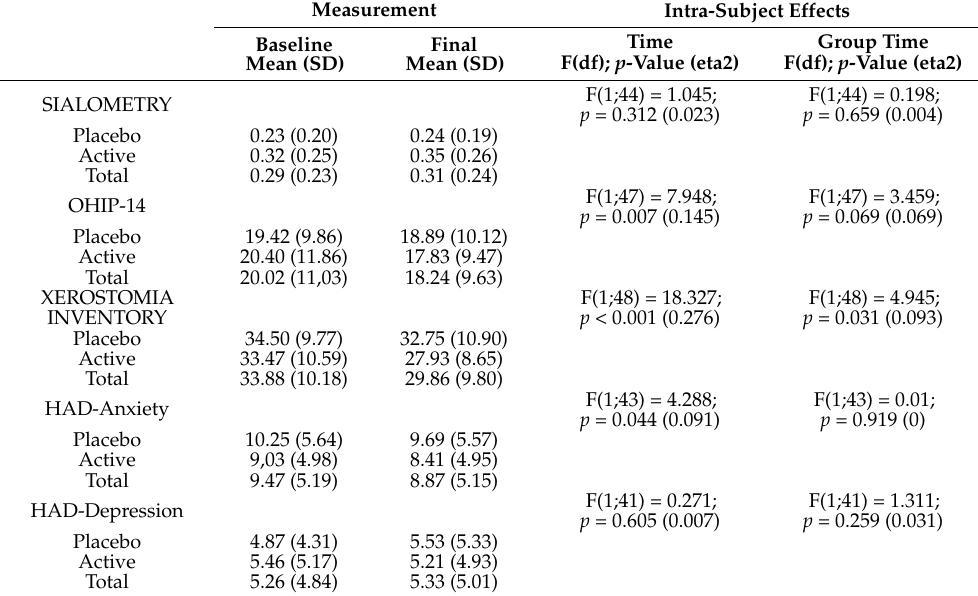
Table 1. Study measurements at baseline and after four weeks of active treatment or placebo.